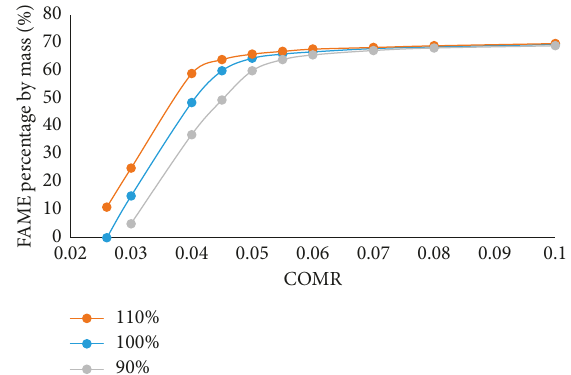
Figure 2: Plots of FAME percentage by mass versus COMR (110% and 90% curves were obtained by simulation with 10% higher and 10% lower COMR than nominal).